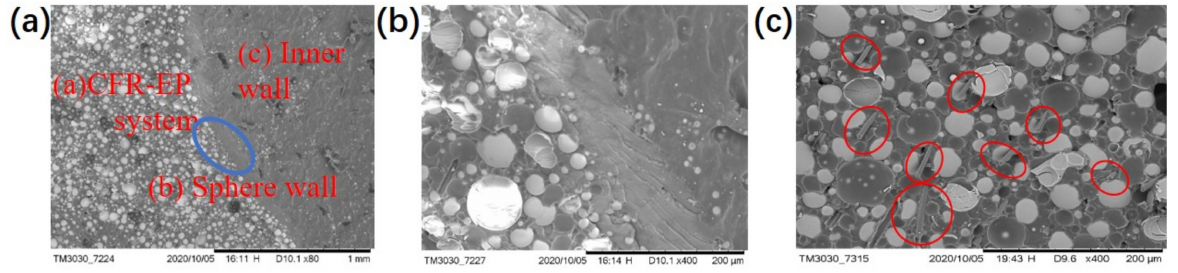
Figure 17. SEM image of the sphere wall and matrix.